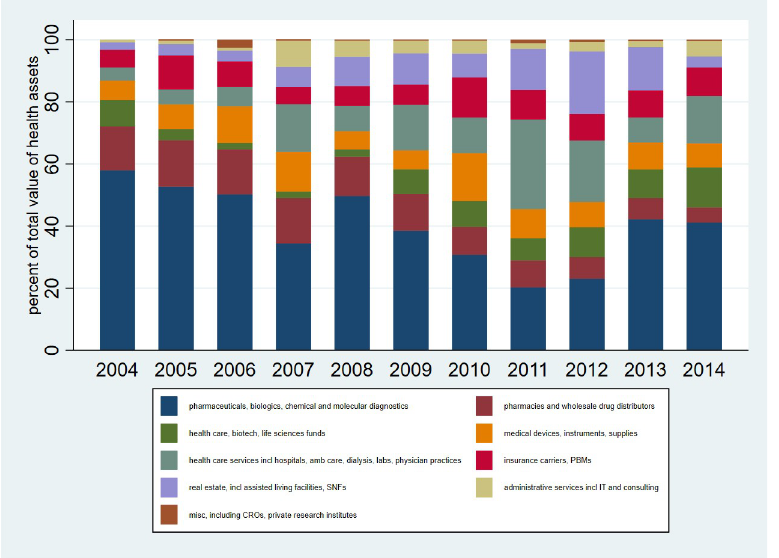
Fig 3. Share of health care-related asset value attributable to different